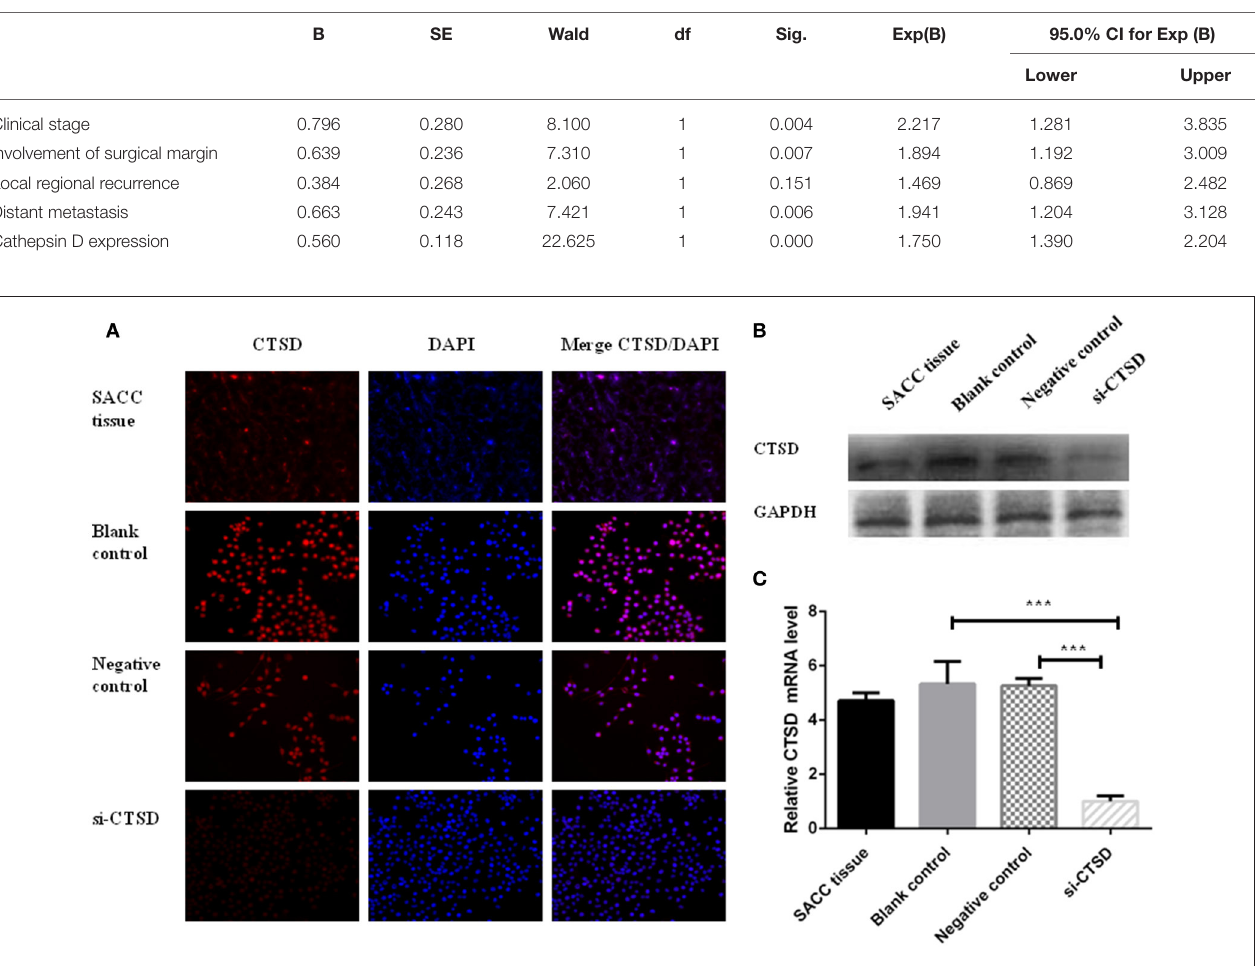
TABLE 3 | Multivariate survival analysis for prognostic factors of SACC patients using a Cox regression. B SE Wald df Sig. Exp(B) 95.0% CI for Exp (B)